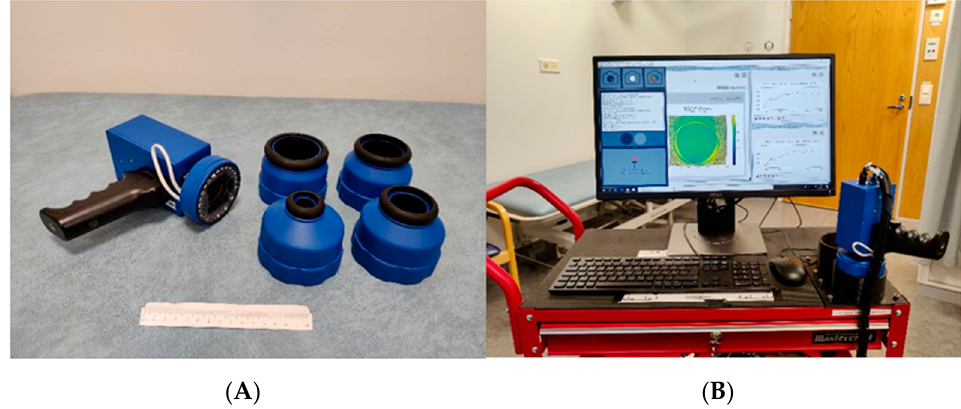
Figure 1. The SICSURFIS imager, light-emitting diode (LED) module, and stray light protection cones ( A ). The imaging setup and software ( B ). Image source [18] .